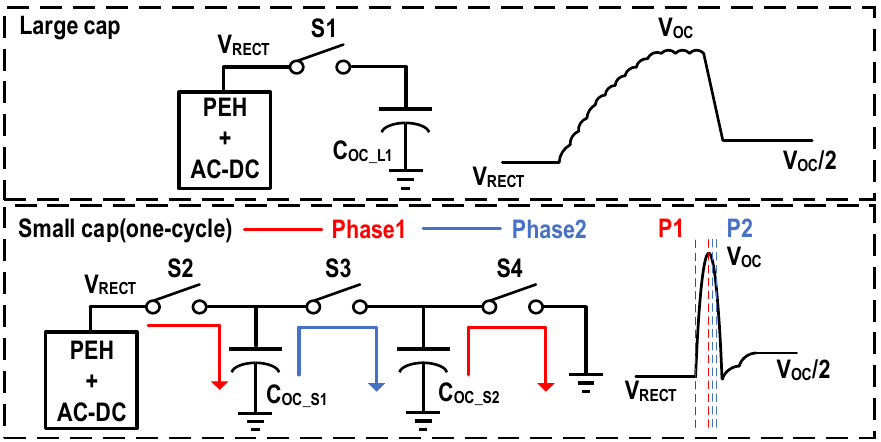
Figure 17. Comparison of the conventional FOCV and the one-cycle open-circuit voltage detection. Table 4. Comparison of the MPPT circuits based on the P&O and the FOCV.